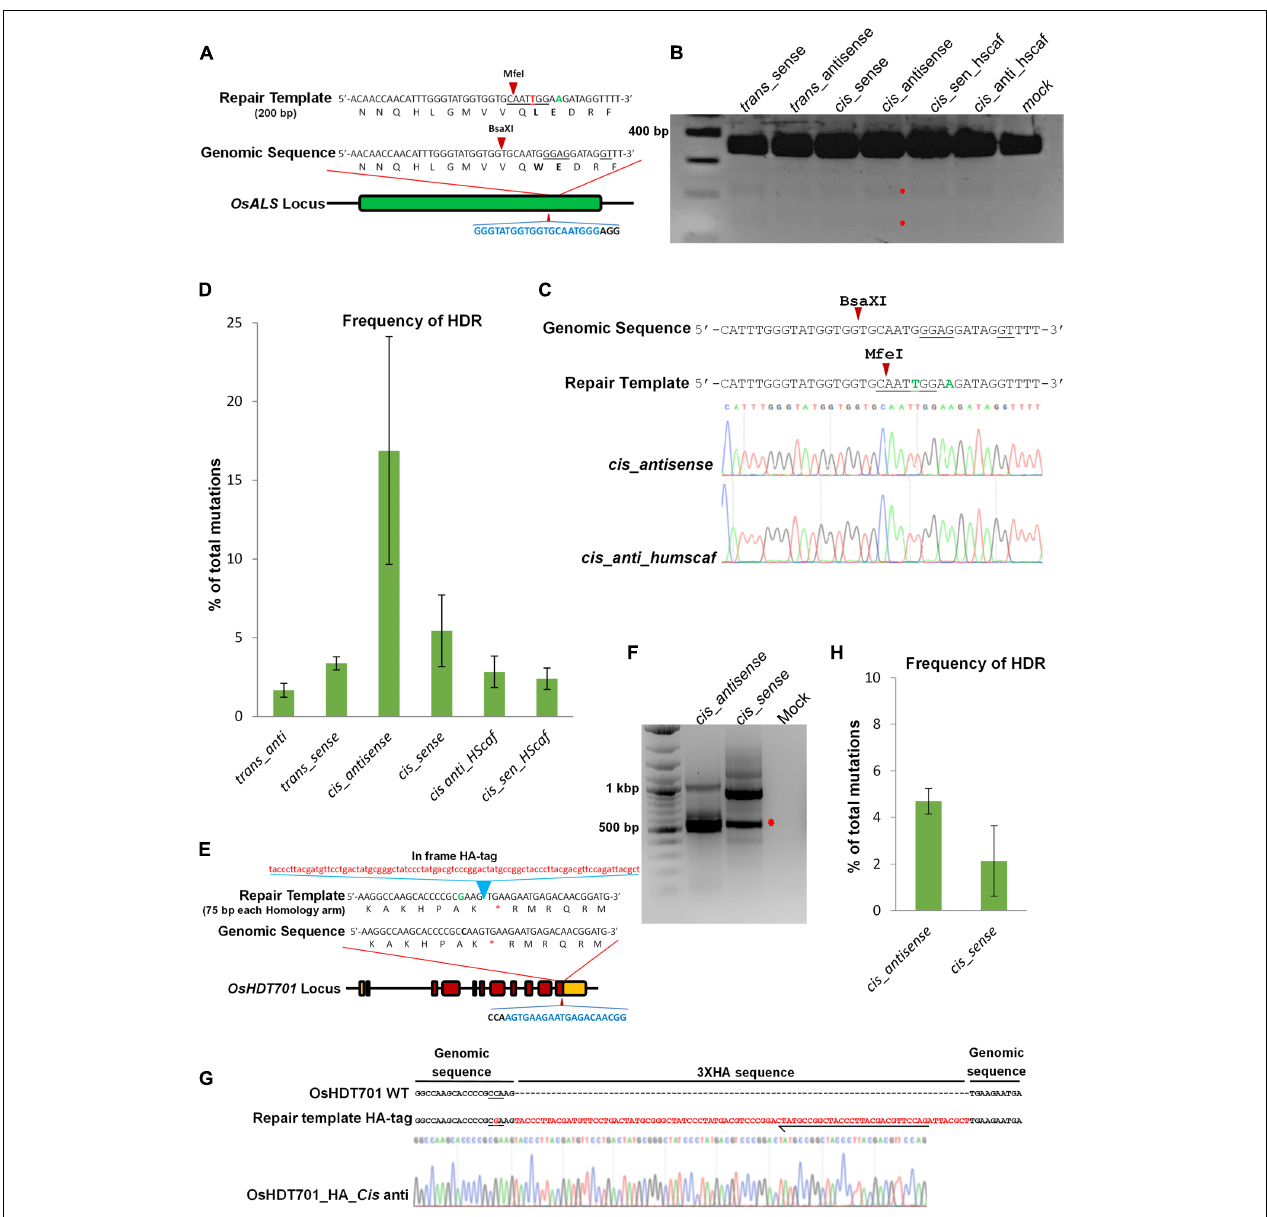
FIGURE 2 | Homology-directed repair in rice protoplasts. (A) The target sequences in the OsALS ( LOC_Os02g30630 ) locus. Blue nucleotides represent gRNA sequence and the PAM sequence is in black. The wild-type sequence has the BsaXI site underlined. Repair from the template introduces two substitutions, one in the PAM sequence G to A (green) and the other G to T (red). The second substitution destroys the BsaXI site and introduces an MfeI site (underlined). Arrows indicate an enzyme cutting site. (B) Genome-editing at the ALS locus in rice protoplasts. Rice protoplasts were transfected with the same gRNA and Cas9 but different repair templates, as indicated. DNA was extracted from protoplasts and enriched with BsaXI and PCR products were digested with MfeI to detect nucleotide substitutions. The red asterisks indicate the digested bands. (C) The selected PCR fragments were cloned and Sanger sequenced. For cis-antisense , 16 out of 96 (16.67% of total reads) have indels and 2 (12.5% of mutated reads) of these were repaired. For cis-anti_humscaff , 69 out of 253 (27.27% of total reads) have indels and 1 (3.70% of mutated reads) of these was repaired. (D) PCR was performed using genome-specific primers. Amplicons were deep sequenced and analyzed using CRISPResso software. The Ratio of HDR among total mutations was calculated. The cis-antisense template showed the highest repair efficiency. Error bars represent SE ( n = 3). (E) The target sequences at the OsHDT701 ( LOC_Os05g51830 ) locus. Blue nucleotides represent the gRNA sequence and black nucleotides represent the PAM sequence. The repair template is 237 bp long including 87 bp of 3XHA-tag. (F) Protoplasts were transfected with HA-tagged repair templates as indicated. DNA was extracted and allele-specific PCR was conducted. Red asterisks indicate the expected PCR product size. (G) Gel elution was done and after cloning, Sanger sequencing was performed which showed the insertion of the HA-tag sequence in the genome. Black arrow represents the position of reverse primer used for allele-specific PCR. PAM sequence underlined. (H) PCR amplification was done using genome-specific primers from the transfected protoplast DNA. Amplicon deep sequencing was done and analyzed by CRISPResso software. cis- antisense showed higher efficiency compared to the cis-sense repair template. Error bars represent SE ( n = 3).